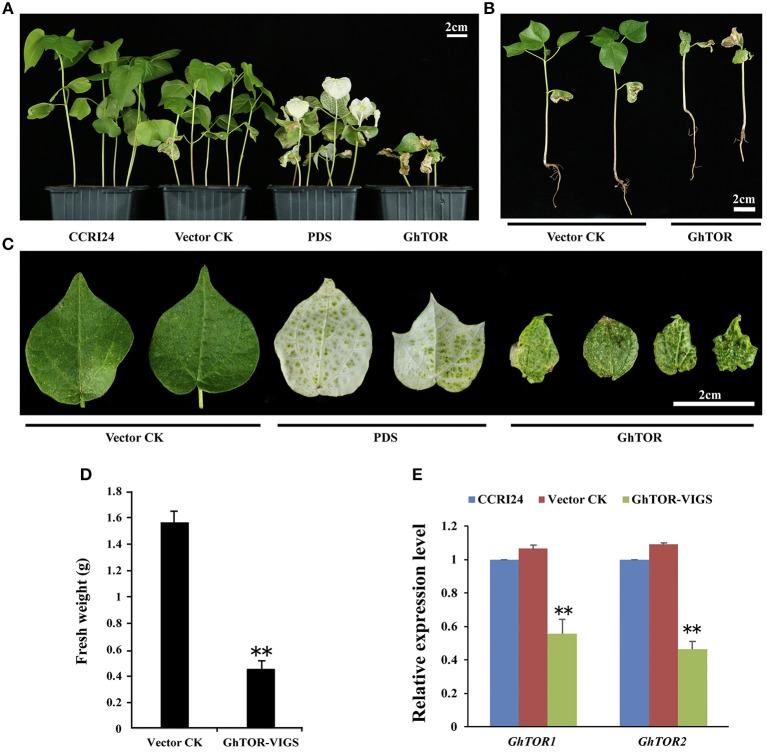
Phenotypes of GhTOR VIGS cotton plants. (A) Potting of wild type plants (CCRI24), and plants infiltrated with vector control (TRV:00), vector containing GhPDS (TRV:GhPDS) and vector containing GhTOR (TRV:GhTOR). Bar = 2 cm. (B) The whole vector control and GhTOR silenced cotton seedlings. Bar = 2 cm. (C) Close-up of vector control, GhPDS-silenced and GhTOR-silenced cotton leaves. Bar = 2 cm. (D) Fresh weight of the control and GhTOR-silenced cotton plants. Each experiment contains three biological replicates, and every replication contains at least twenty plants. Error bars indicate ±SD for triplicates. Significant differences from the control are indicated by **P < 0.01. (E) Decreased GhTOR expression levels in VIGS plants. Total RNA was extracted from leaves at 14 days post-agroinfiltration. The expression level of GhTOR1 (GhTOR1-At and GhTOR1-Dt) and GhTOR2 (GhTOR2-At and GhTOR2-Dt) in VIGS plants was compared with that in wild type plants (CCRI24) and plants infiltrated with vector control. Asterisks denote significant difference compared with wild-type plants (CCRI24) (**P < 0.01).